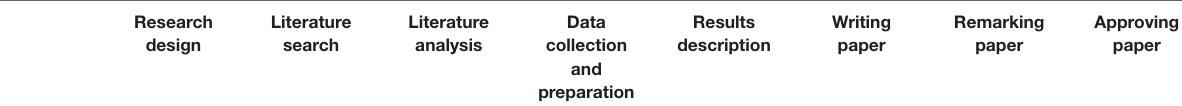
TABLE 7 | Comparison of strength of the marginal effects from model 15 in Table 6